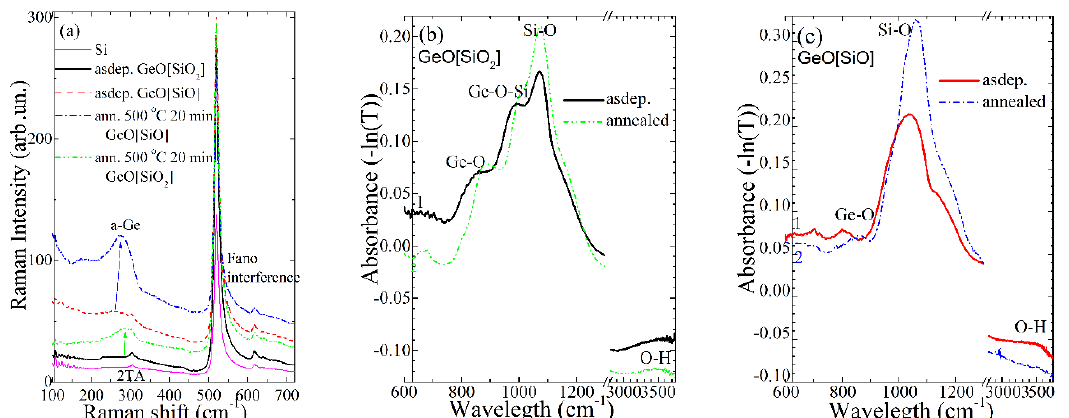
Figure 3. ( a ) Raman spectra of the GeO[SiO 2 ] and GeO[SiO] thin films, measured before and after annealing at 500 °C for 20 min. A Raman spectrum from a virgin Si (001) substrate is also shown. ( b ) Fourier-transform infrared spectroscopy (FTIR) absorption spectra of the thick GeO[SiO 2 ] film (reference sample grown on a substrate not heavily doped with Si), measured before and after annealing. ( c ) FTIR absorption spectra of the thick GeO[SiO] film (reference sample grown on a substrate not heavily doped with Si), measured before and after annealing.